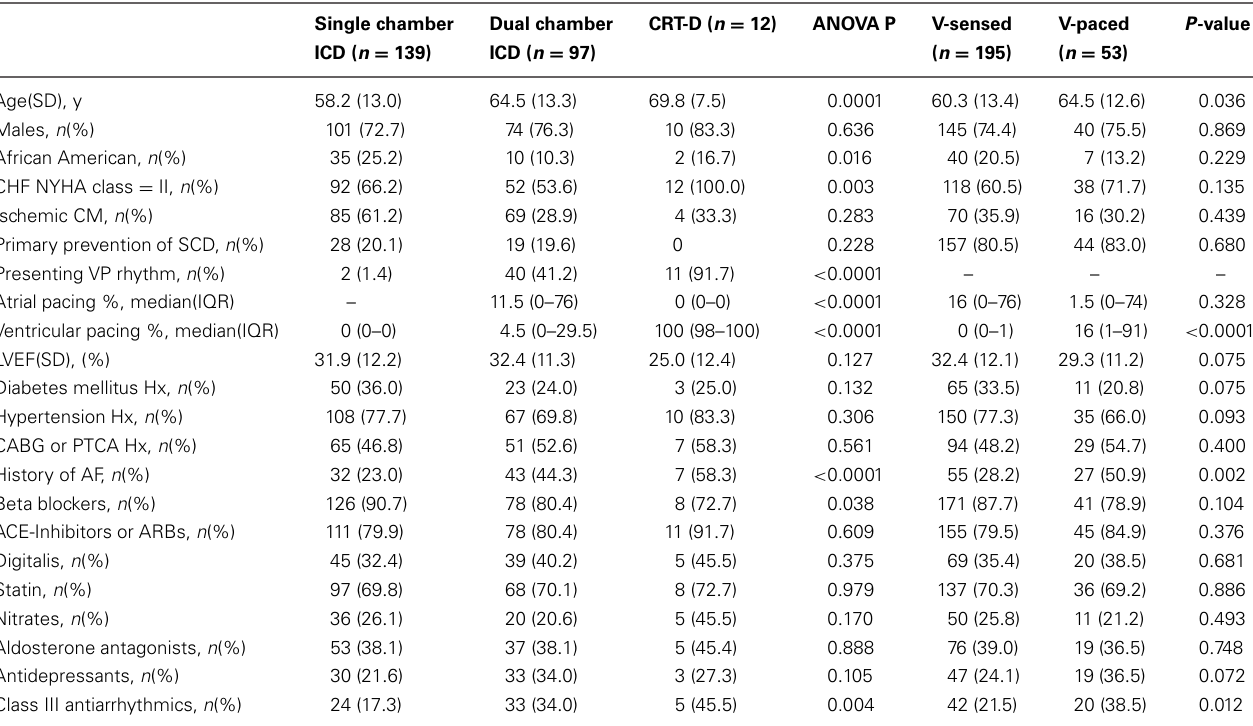
Table 1 | Comparison of demographic and clinical characteristics of patients with single-, dual-chamber ICD, and CRT-D, and in patients with sinus ventricular-sensed and ventricular-paced